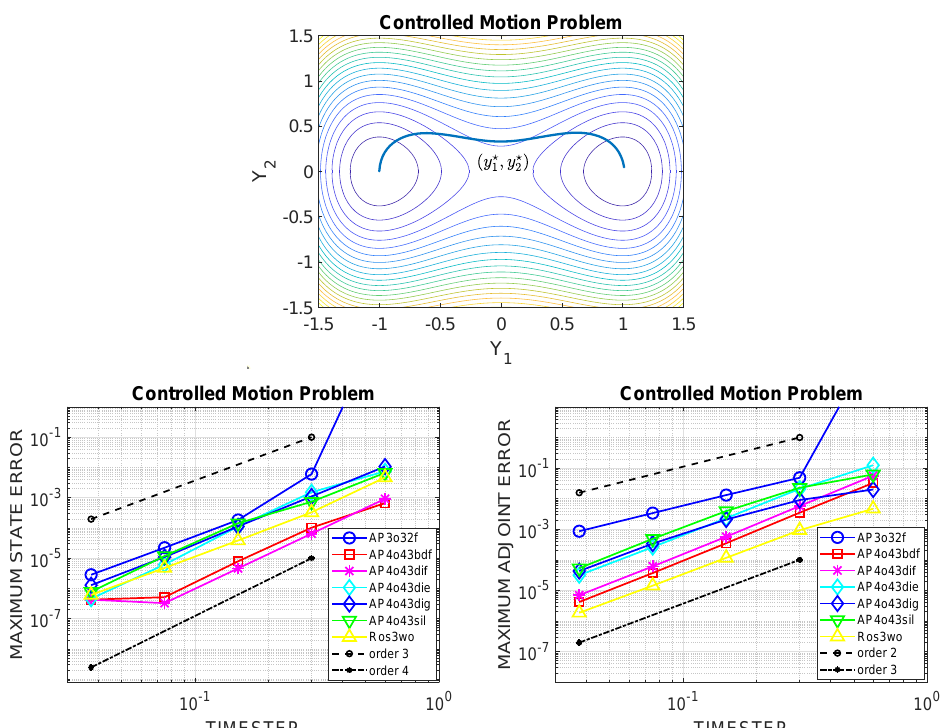
) through the total energy field E = , y (cid:63) 2 1